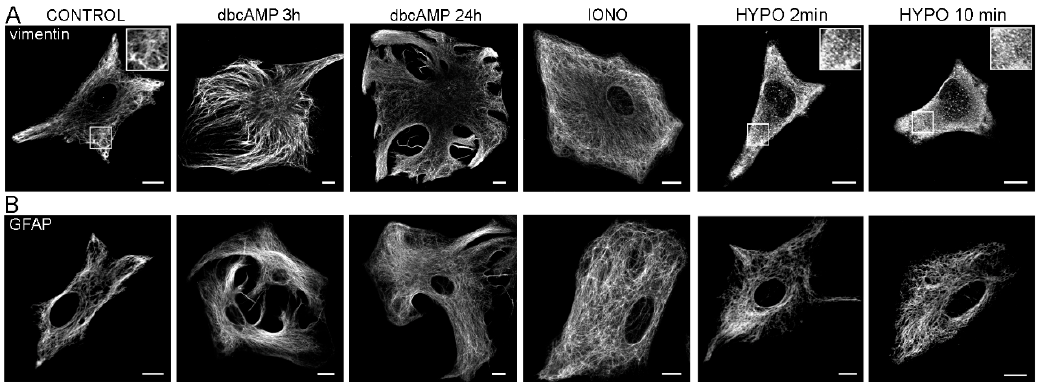
Figure 1. Cellular distribution of GFAP and vimentin cytoskeleton in primary rat astrocytes in normal conditions and in conditions that are typically present in pathological states. Astrocytes treated with dbcAMP (N 6,2 ′ -O -dibutyryladenosine 3 ′ :5 ′ cyclic monophosphate), a membrane-permeable analogue of cAMP, mimic general reactive gliosis. Hypotonic stimulation, on the other hand, leads readily to astrocyte swelling, which is a part of the cytotoxic or cellular edema response. Changes in intracellular arrangement of vimentin ( A ) and GFAP ( B ) filaments are evident in reactive astrocytes (after cAMP stimulation) and after hypotonic stimulation (HYPO), as revealed by immunolabeling. Note also the stellated morphology of astrocytes after the increase in cAMP. Hypotonic treatment triggered depolymerization of vimentin filaments—selected areas (white squares) are magnified (2 × )—in insets Bars: 10 µ m. Modified with permission from [84] (Regulation of AQP4 Surface Expression via Vesicle Mobility in Astrocytes, GLIA, Copyright © 2013 Wiley Periodicals, Inc., (Hoboken, NJ,